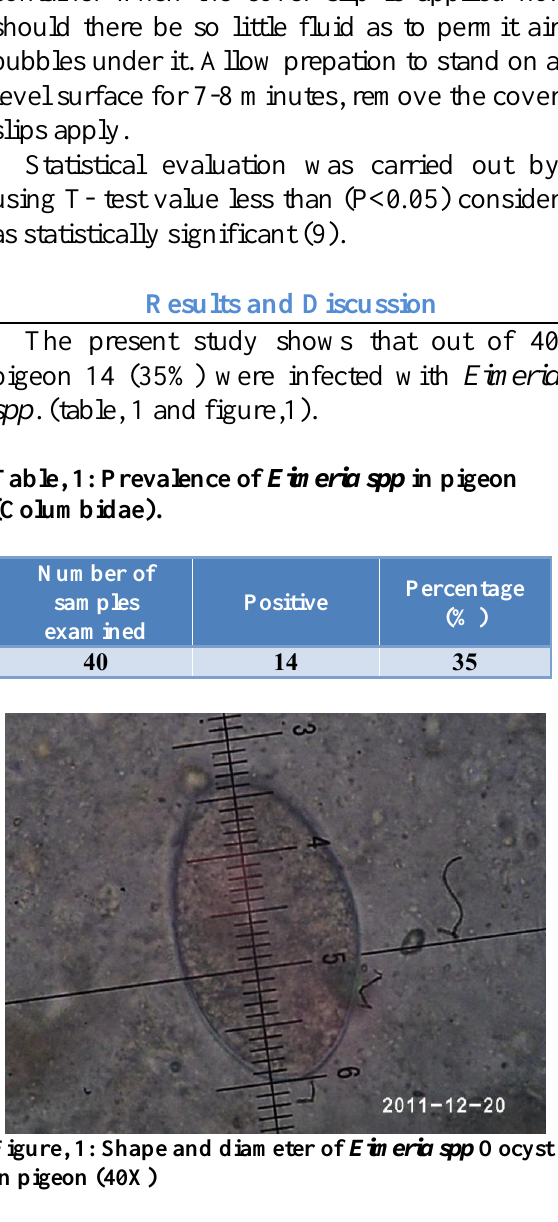
Figure, 1: Shape and diameter of Eimeria spp Oocyst in pigeon (40X)